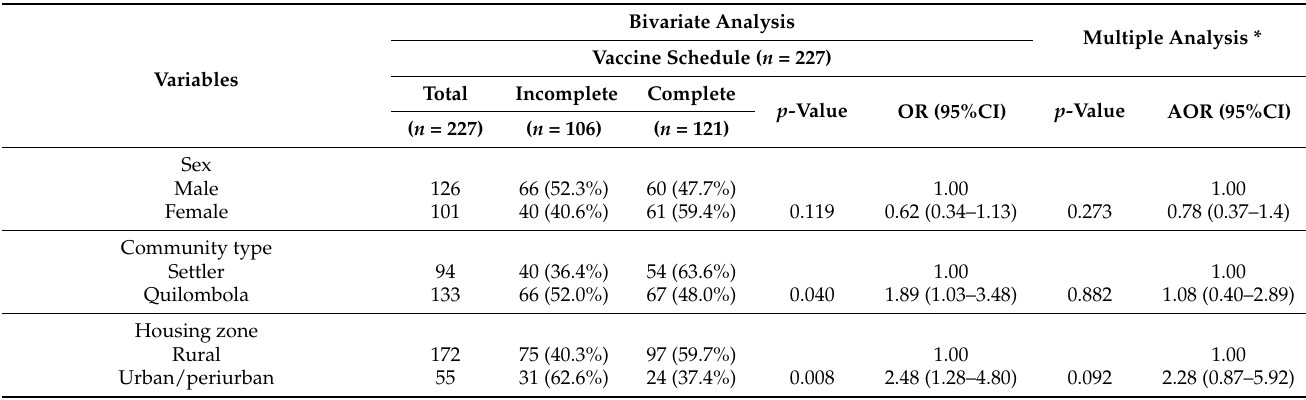
Table 4. Factors associated with incomplete general vaccination coverage for the first year. Goi á